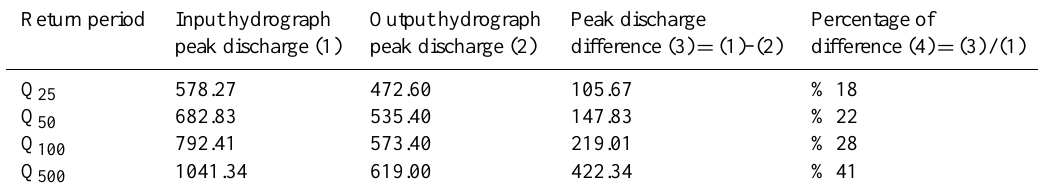
Table 2. Scenario1 model results.